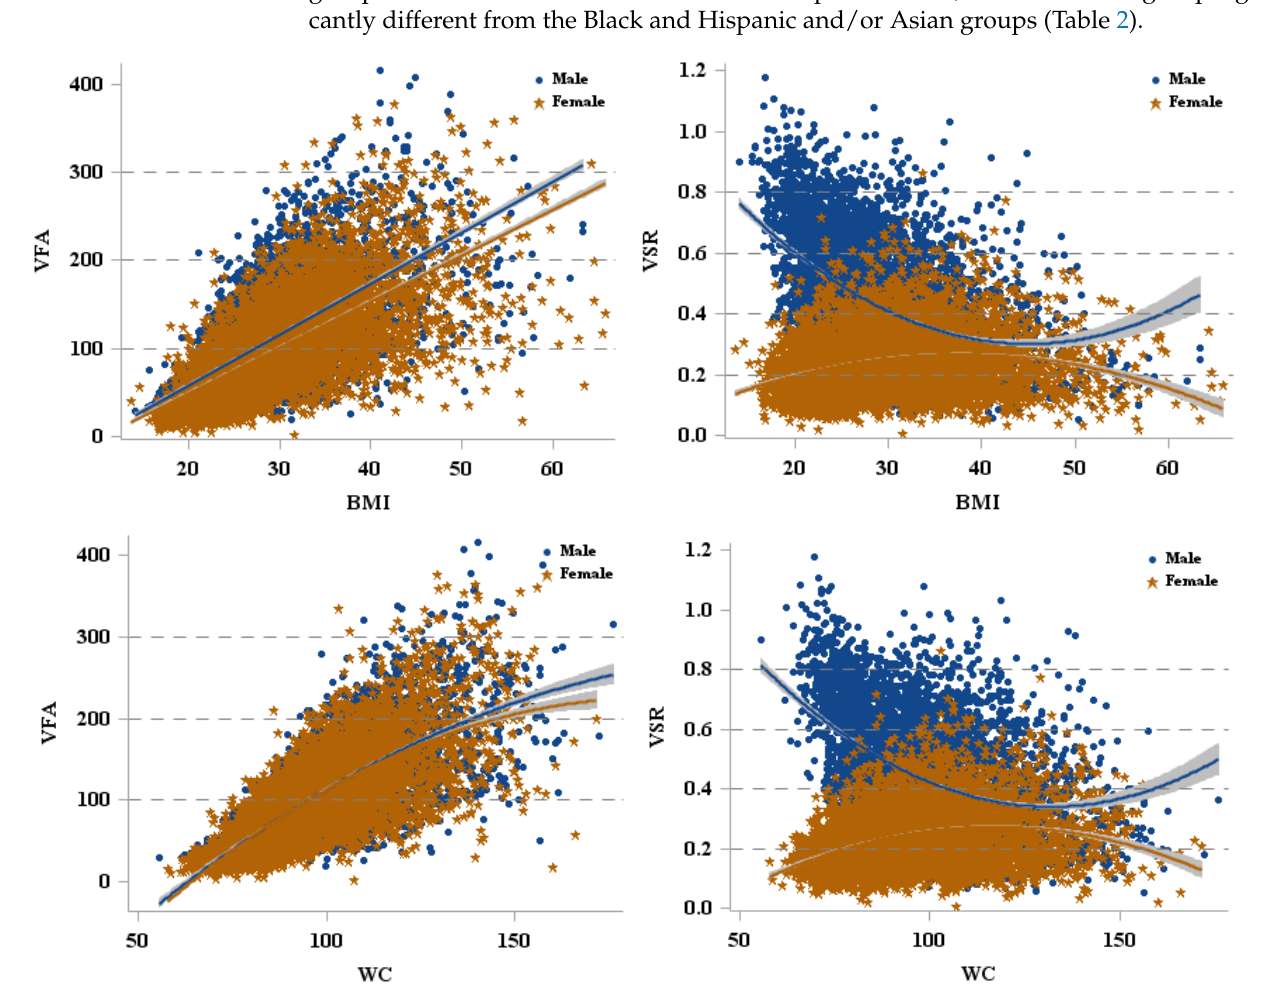
Figure 4. The relationships between VFA and VSR with BMI, WC. VFA = visceral fat area, VSR = visceral to subcutaneous adipose area ratio, BMI = body mass index, WC = waist circumference. There was either a concave (male) or convex curvilinear (female) relationship between BMI and WC with VSR (Figure 4). In addition, due to the opposite relationships between BMI and VSR, WC and VSR, we reported the results for males and females separately (Figure 4). In males, when BMI < 39.08 kg/m 2 , BMI was negatively associated with VSR; however, when BMI ≥ 39.08 kg/m 2 , the relationship between these two variables was reversed, with a higher BMI associated with a higher VSR. In females, BMI was positively associated with VSR until it reached 38.75 kg/m 2 but was inversely associated with VSR for BMIs ≥ 38.75 kg/m 2 . A similar pattern was observed between WC and VSR in males and females. Furthermore, the relationships between BMI or WC and VSR were different in racial/ethnic groups, with Black significantly different from White, Hispanic, and Asian (Table 3).